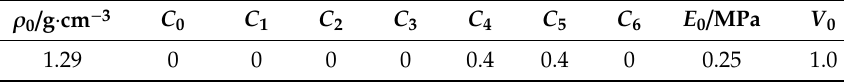
Table 2. Material model and the EOS (Equation of State) parameters of air [23,24].